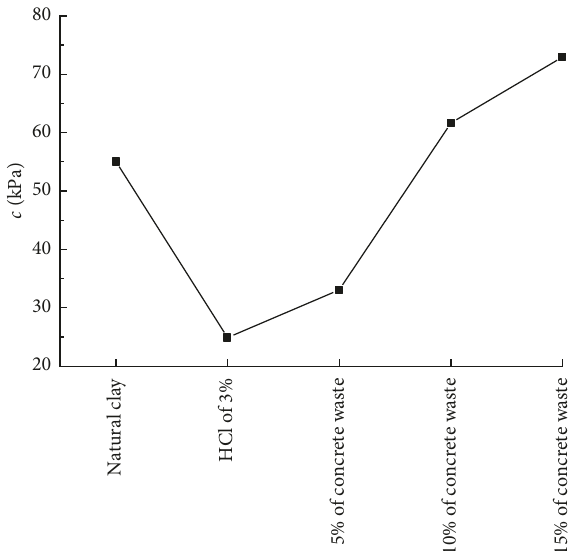
Figure 14: Variation in internal friction angle of crushed concrete waste-cured acid-contaminated